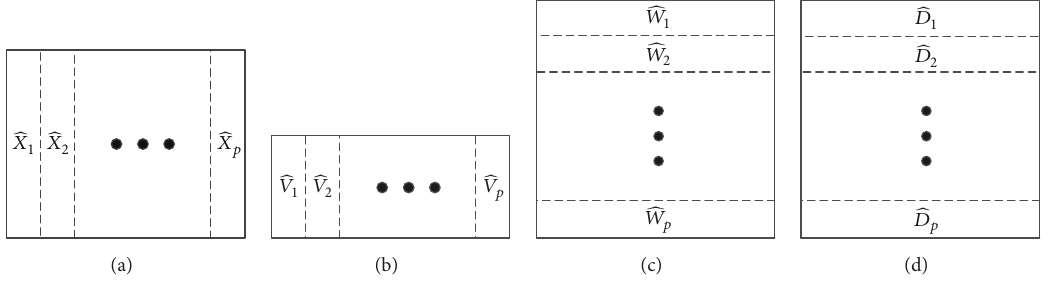
Figure 1: Data partitioning strategy for updating 𝑉 in PNMF-M.